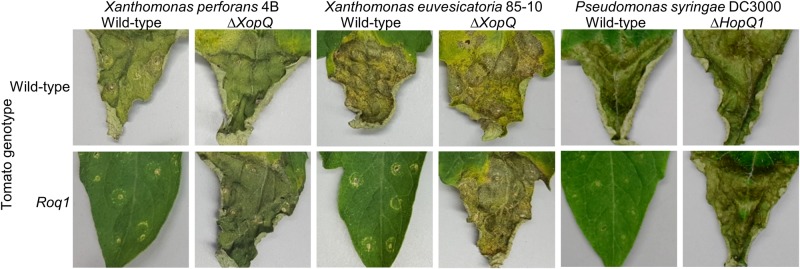
Bacterial disease symptoms on Roq1 tomato. Xanthomonas perforans 4B (Xp), Xanthomonas euvesicatoria 85-10 (Xe), and Pseudomonas syringae DC3000 (Ps) wild-type and XopQ/HopQ1 knockout strains were infiltrated into tomato leaf tissue at low inoculum and disease symptoms were imaged at 12, 13, and 4 days post infiltration for Xe, Xp, and Ps, respectively. The infiltration was performed using a needleless syringe and circular wounds from the infiltration are visible. The distal part of region of each leaf was infiltrated and the proximal part was left untreated. Xe and Xp were infiltrated at an OD600 of 0.0001 whereas Ps was infiltrated at an OD600 of 0.00005. The images shown here are representative of at least three independent experiments.